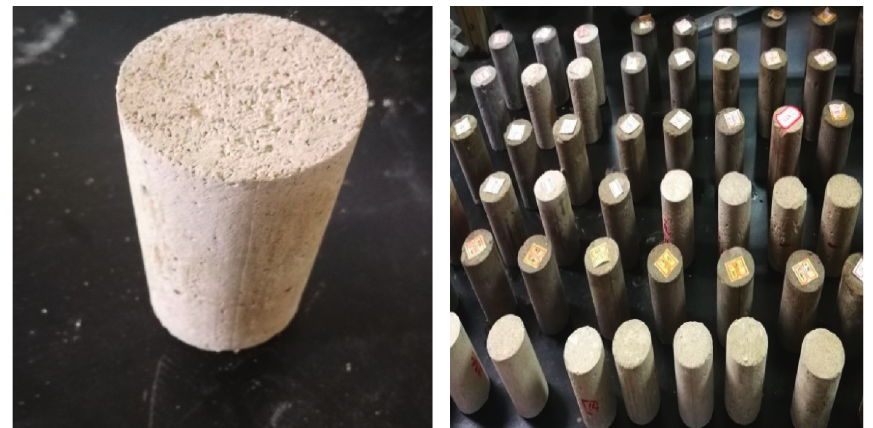
Figure 5: Preparation of self-healing testing